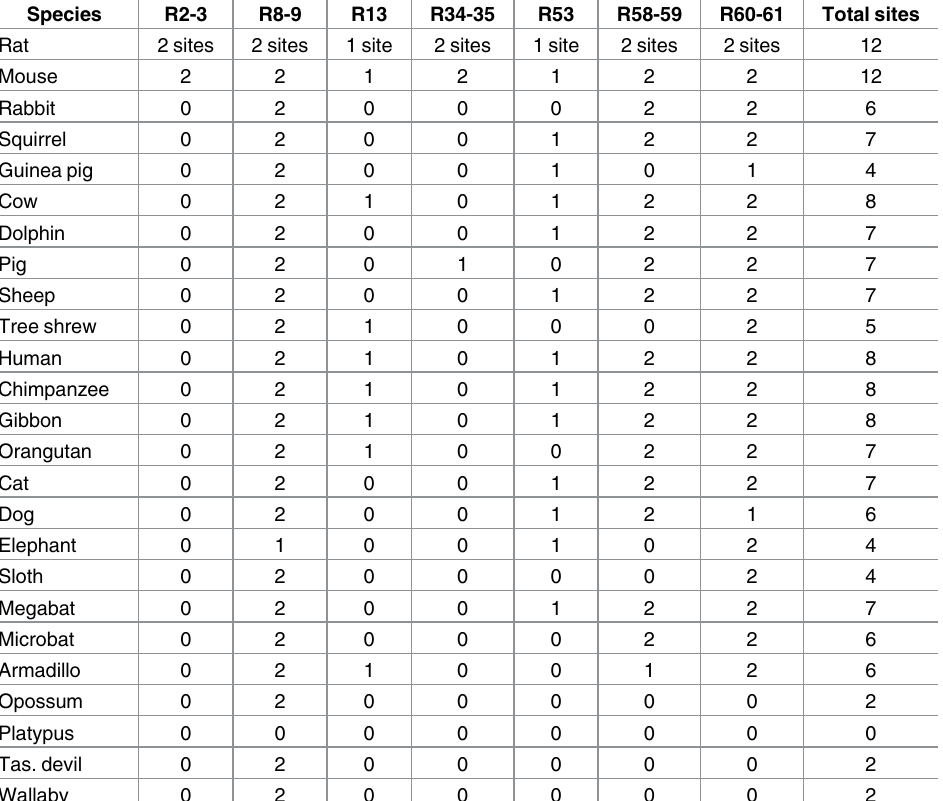
Table 6. Comparison of Stat5b elements in IGF1/Igf1